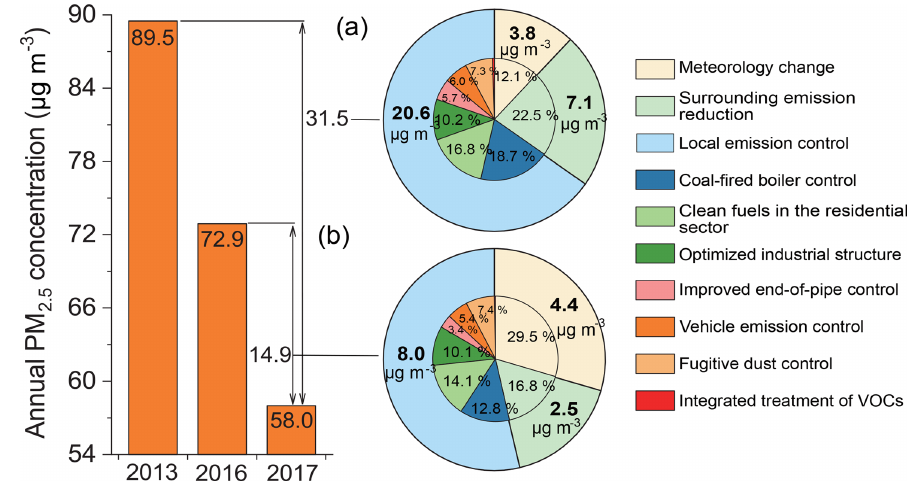
Figure 10. Decomposition of improved PM 2 . 5 air quality in Beijing during (a) 2013–2017 and (b) 2016–2017.